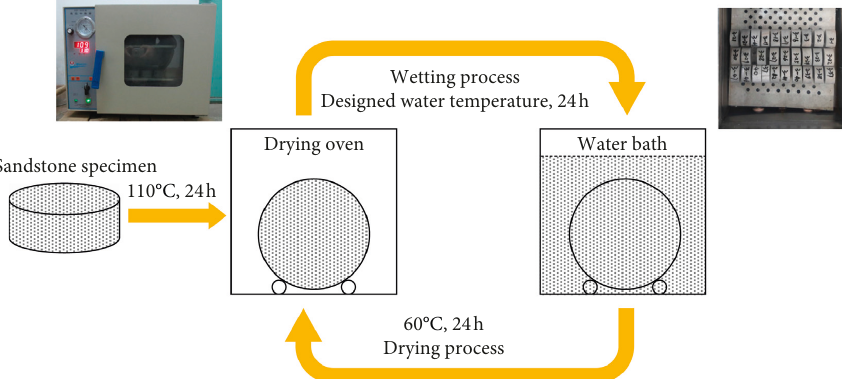
Figure 2: Schematic diagram of cyclic wetting and drying treatment.